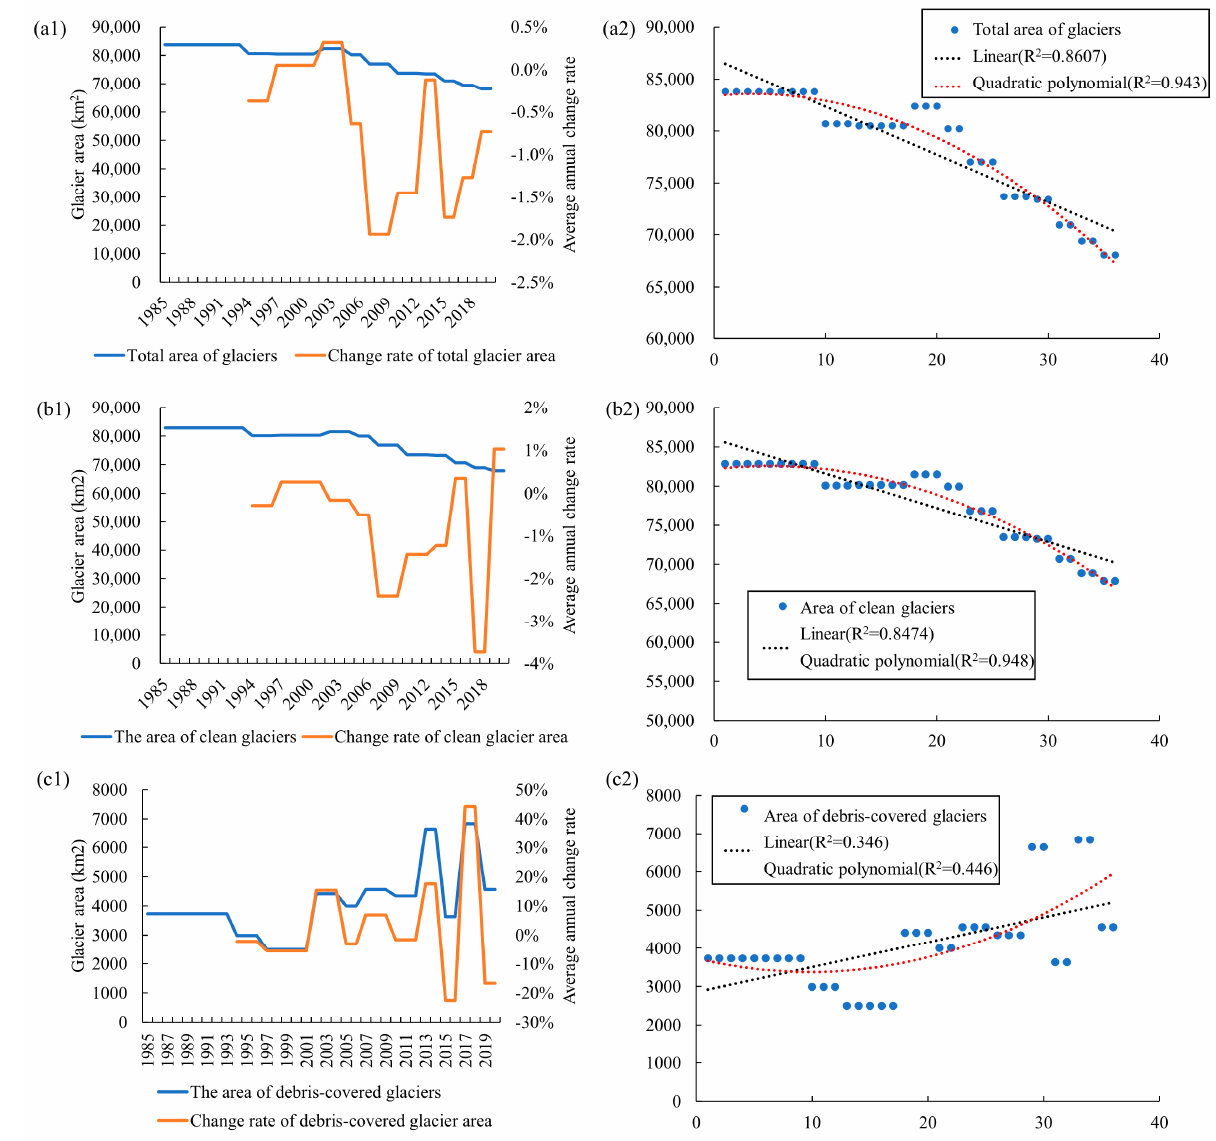
Figure 6. Glacier changes on the Tibetan Plateau from 1985 to 2020. ( a1 ), ( b1 ), ( c1 ) are the areas of total glaciers, clean glaciers, and debris-covered glaciers in each period and their change rates, ( a2 ), ( b2 ), ( c2 ), are the area fitting curves of total glaciers, clean glaciers, and debris-covered glaciers,